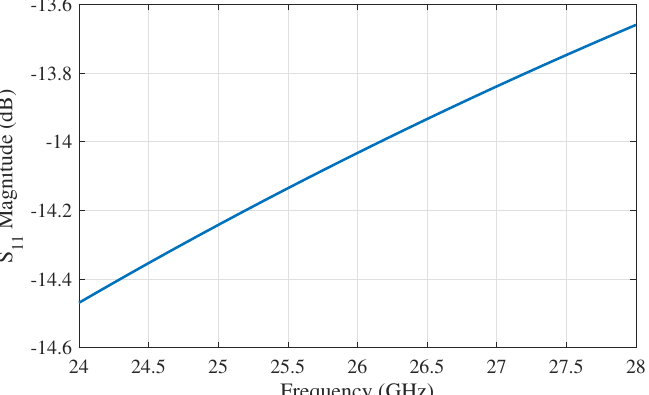
Figure 8. S 11 magnitude as a function of frequency for the microstrip input of the PCB (port 1) to package stripline transition (port 2).